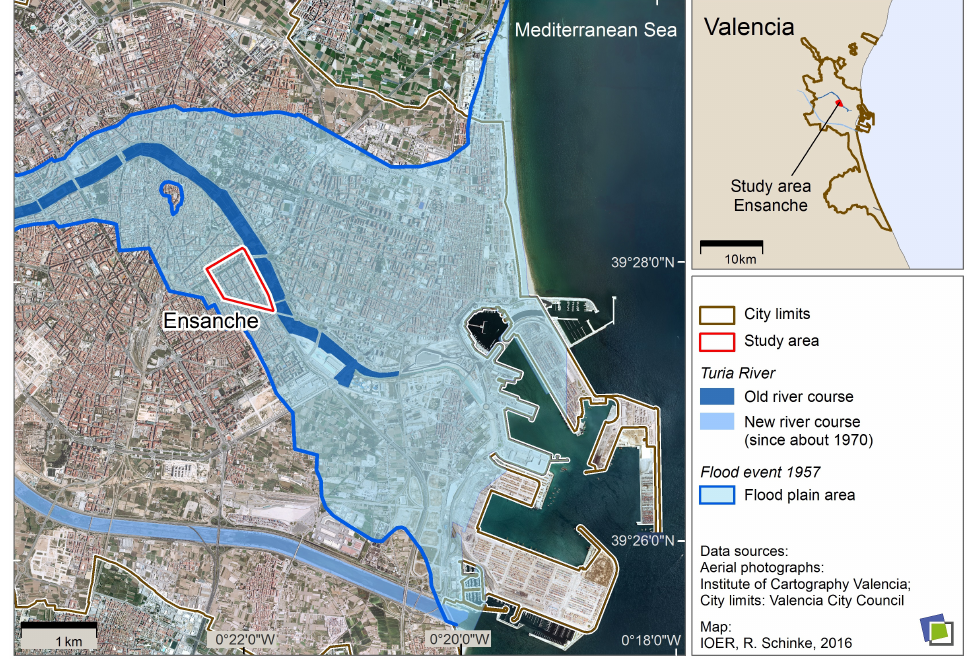
Figure 4. Valencia with the 1957 flood plain and the study area